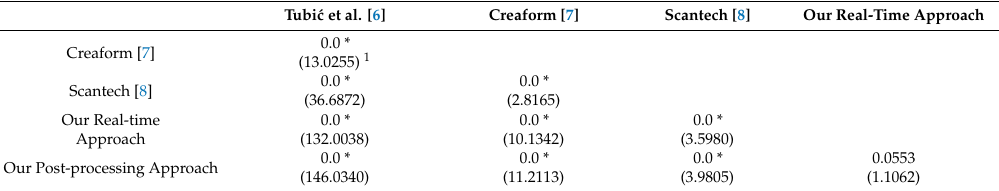
Table 8. F -test for the sheet metal part.